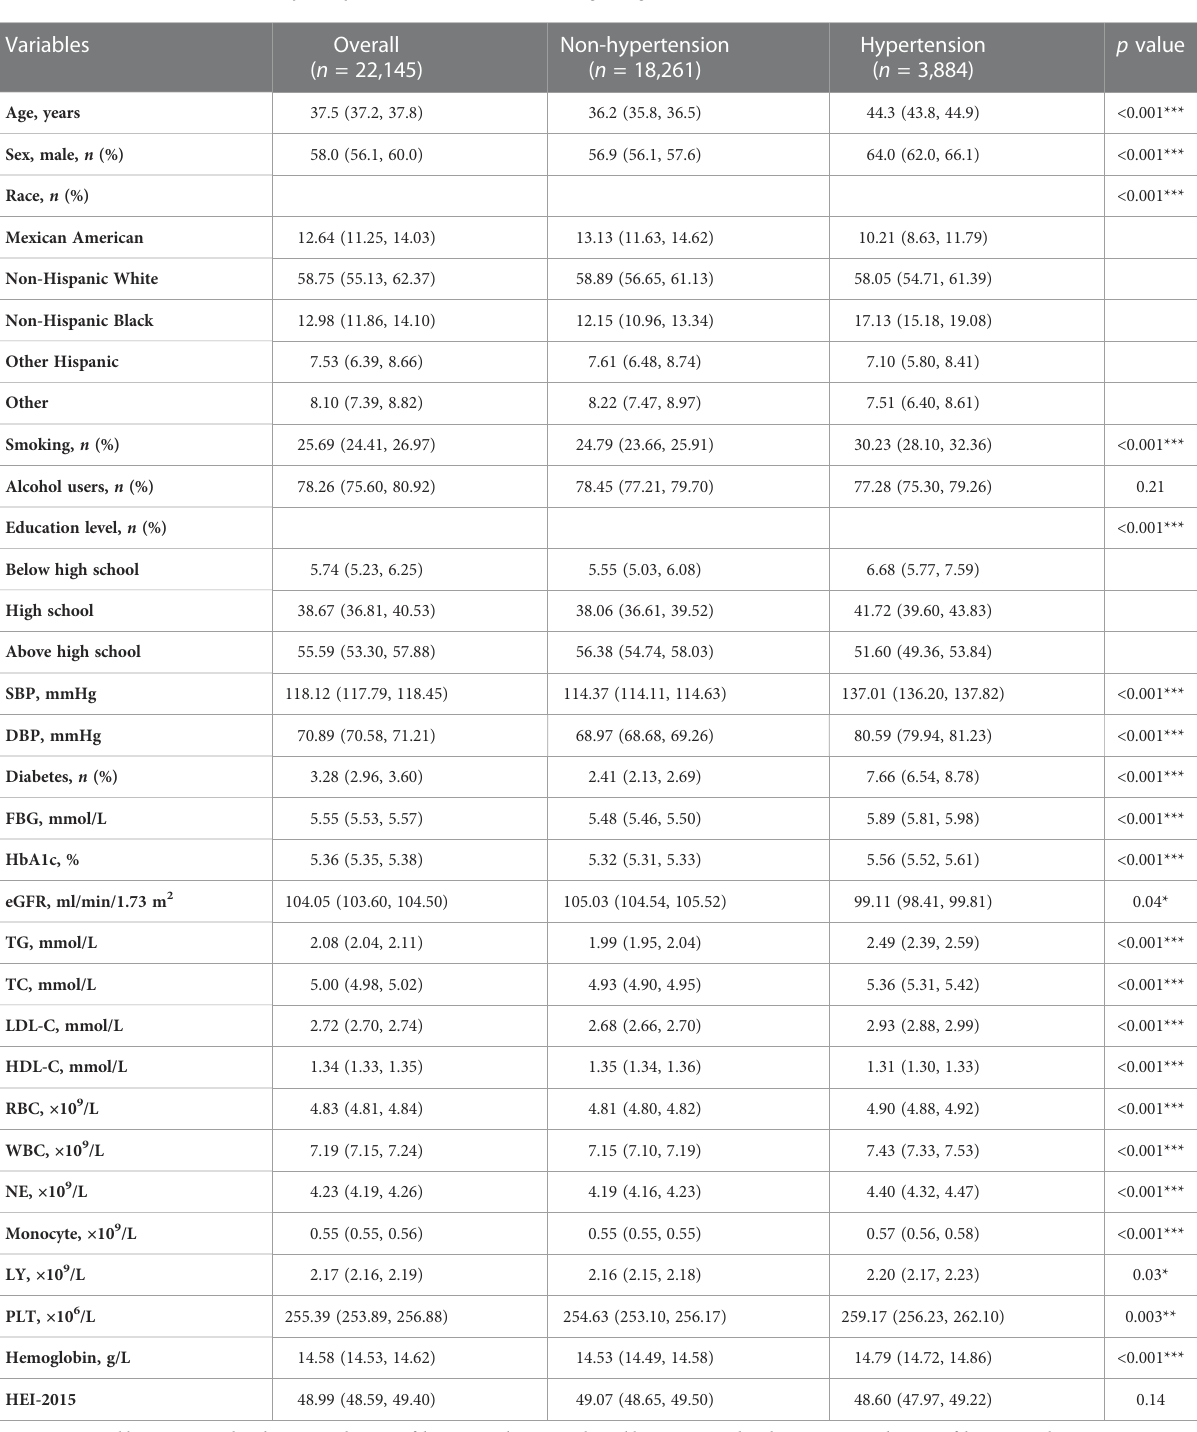
TABLE 1 Baseline characteristics of participants enrolled in the sensitivity